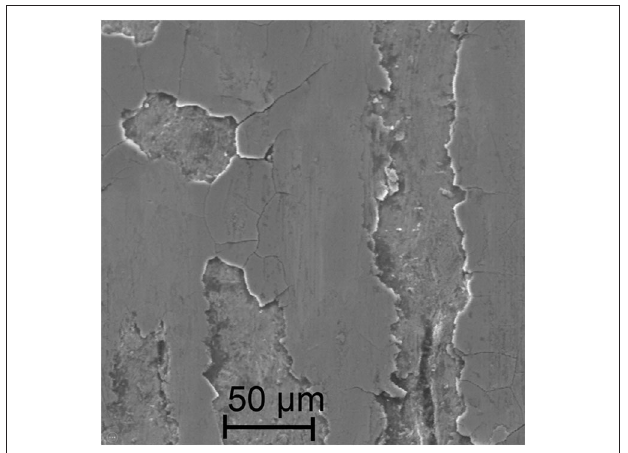
FIGURE 12 | SEM image of tribochemical wear.